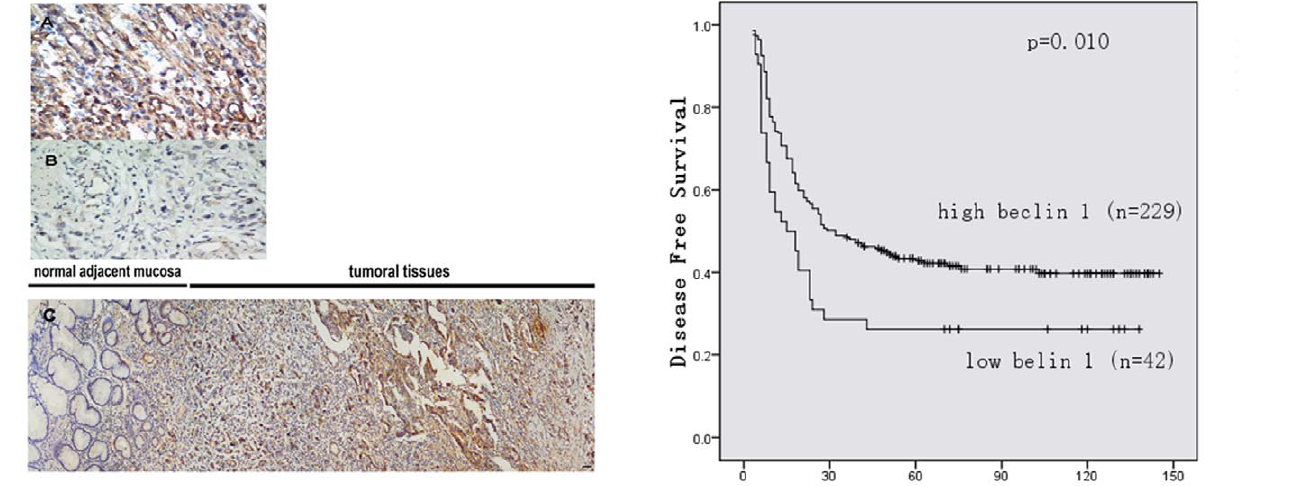
Figure 2. Representative examples of Beclin1 expression. High Beclin 1 (A) and low Beclin 1 (B) expression in human gastric cancer specimens ( 6 400), Beclin 1 positive staining in the tumor and negative staining in normal adjacent mucosa( 6 20) (C).